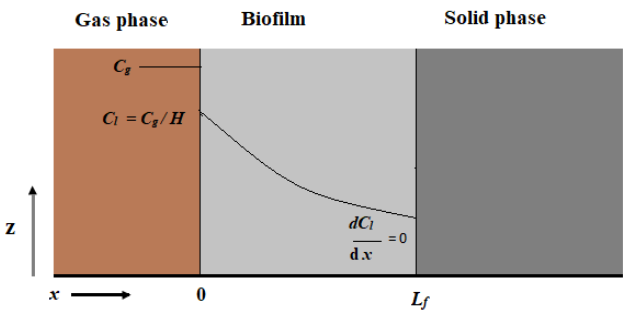
Figure 1. Schematic representation of the NOx concentration distributions in the gas and biofilm